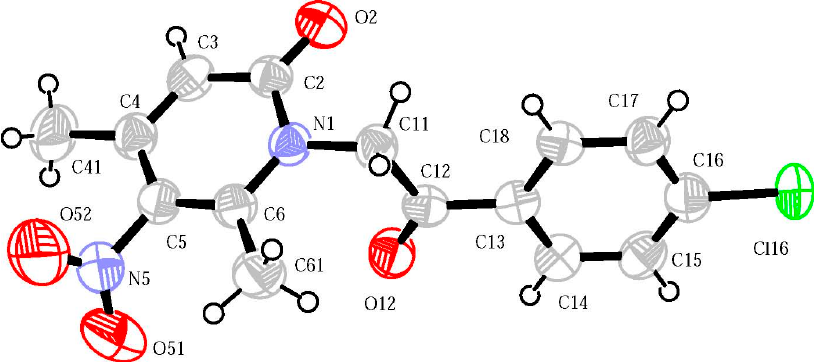
Figure 1. The general view of molecular structure of 4a in representation of atoms by displacement parameters ellipsoids (p = parameters ellipsoids (p = 30%).